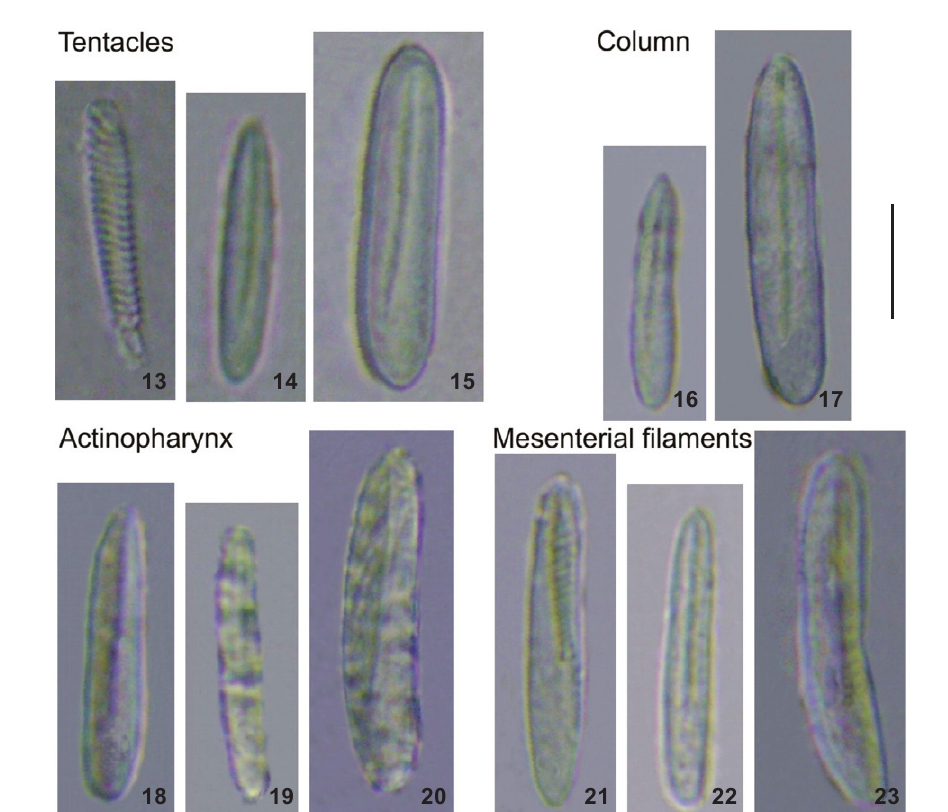
Figures 13-23. Cnidom of Bunodactis octoradiata : (13) spirocyst; (14, 16, 19, 22) basitrich I; (15, 17, 20, 23) basitrich II; (18, 21) microbasic p-mastigophore. Scale bar: 10